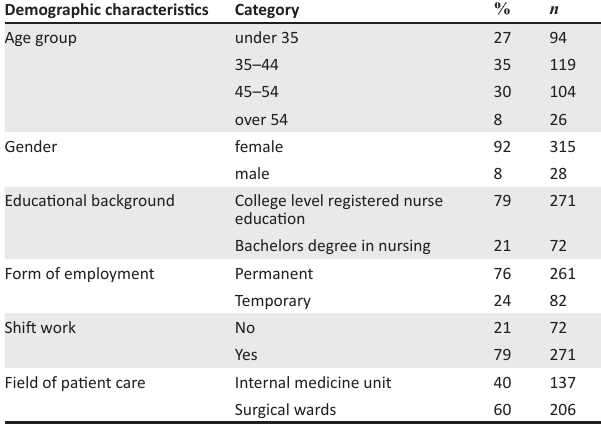
TABLE 1: Demographic characteristics of the respondents ( N =